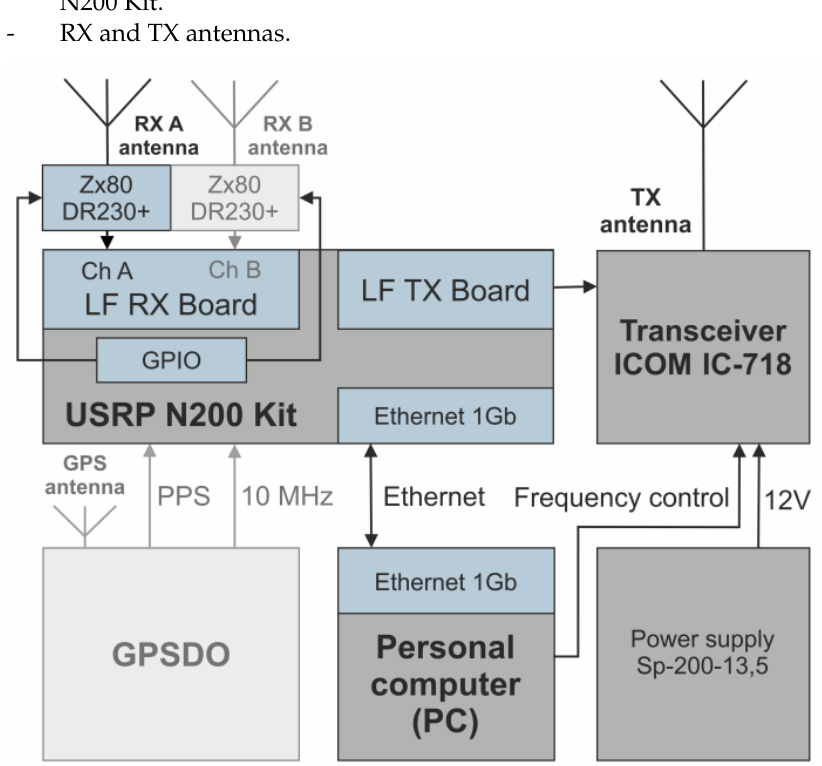
Figure 1. Block diagram of the ionosonde. Light gray blocks (GPSDO and receiving channel B) are optional for the base configuration and are used in the extended configuration.